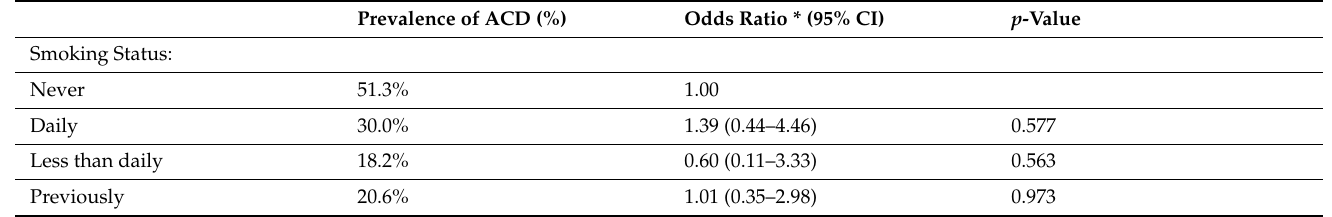
Table 3. Effect of smoking on the prevalence of ACD after adjustment for age and gender.